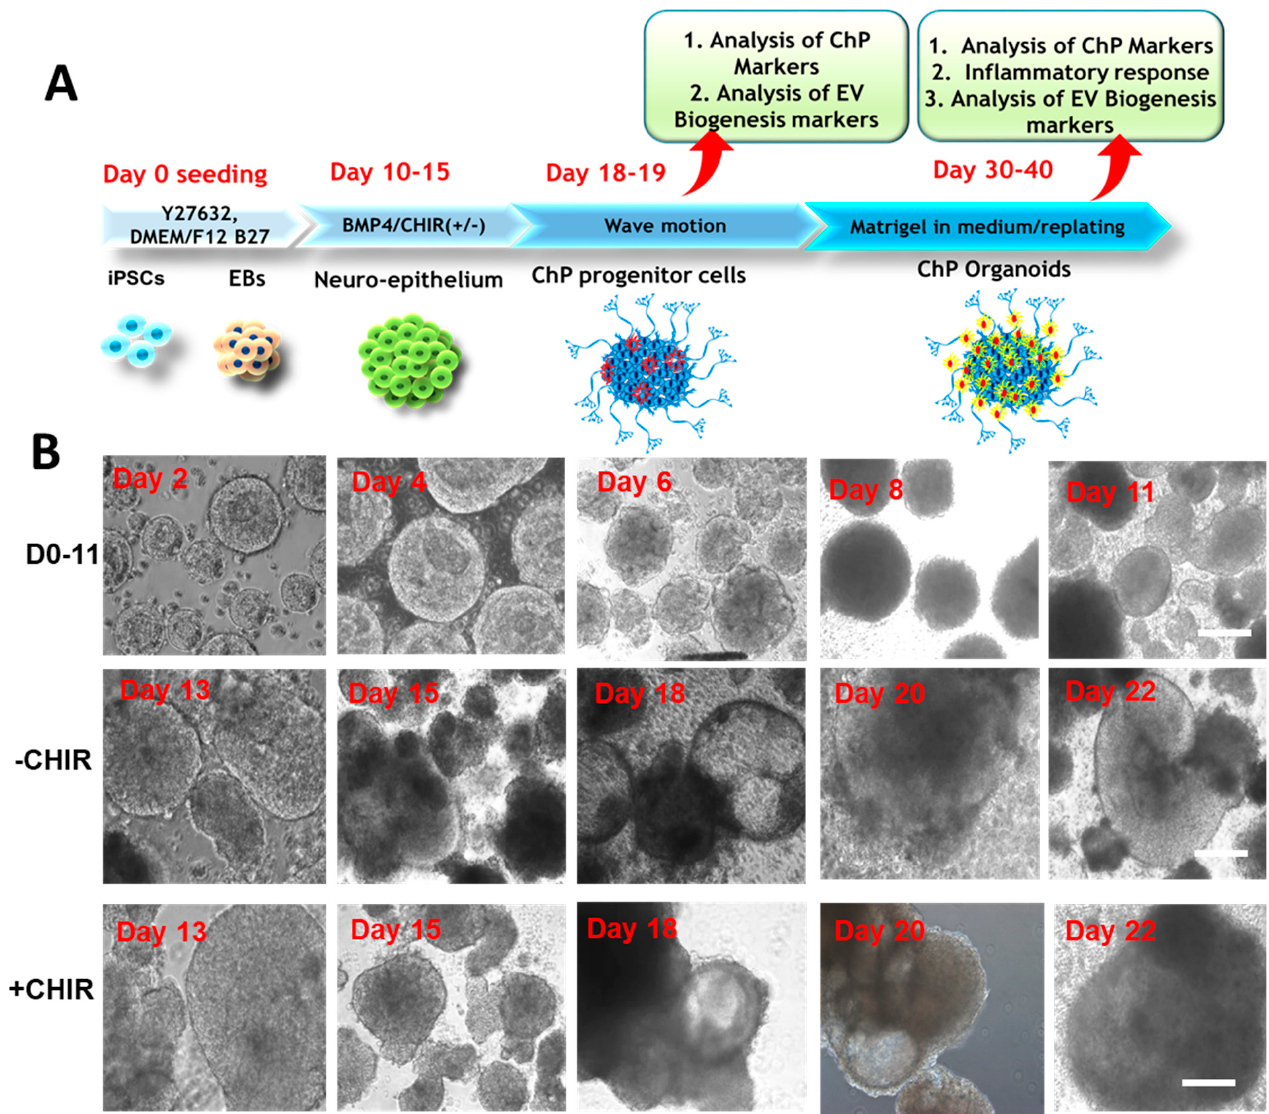
Figure 1. ChP organoid di ff erentiation from hiPSCs. ( A ) Illustration of ChP di ff erentiation; ( B ) the ChP organoid morphology for CHIR+/ − conditions during the di ff erentiation. Scale bar: 200 µm. BMP: bone morphogenetic protein; EBs: embryoid bodies. EV: extracellular vesicles.